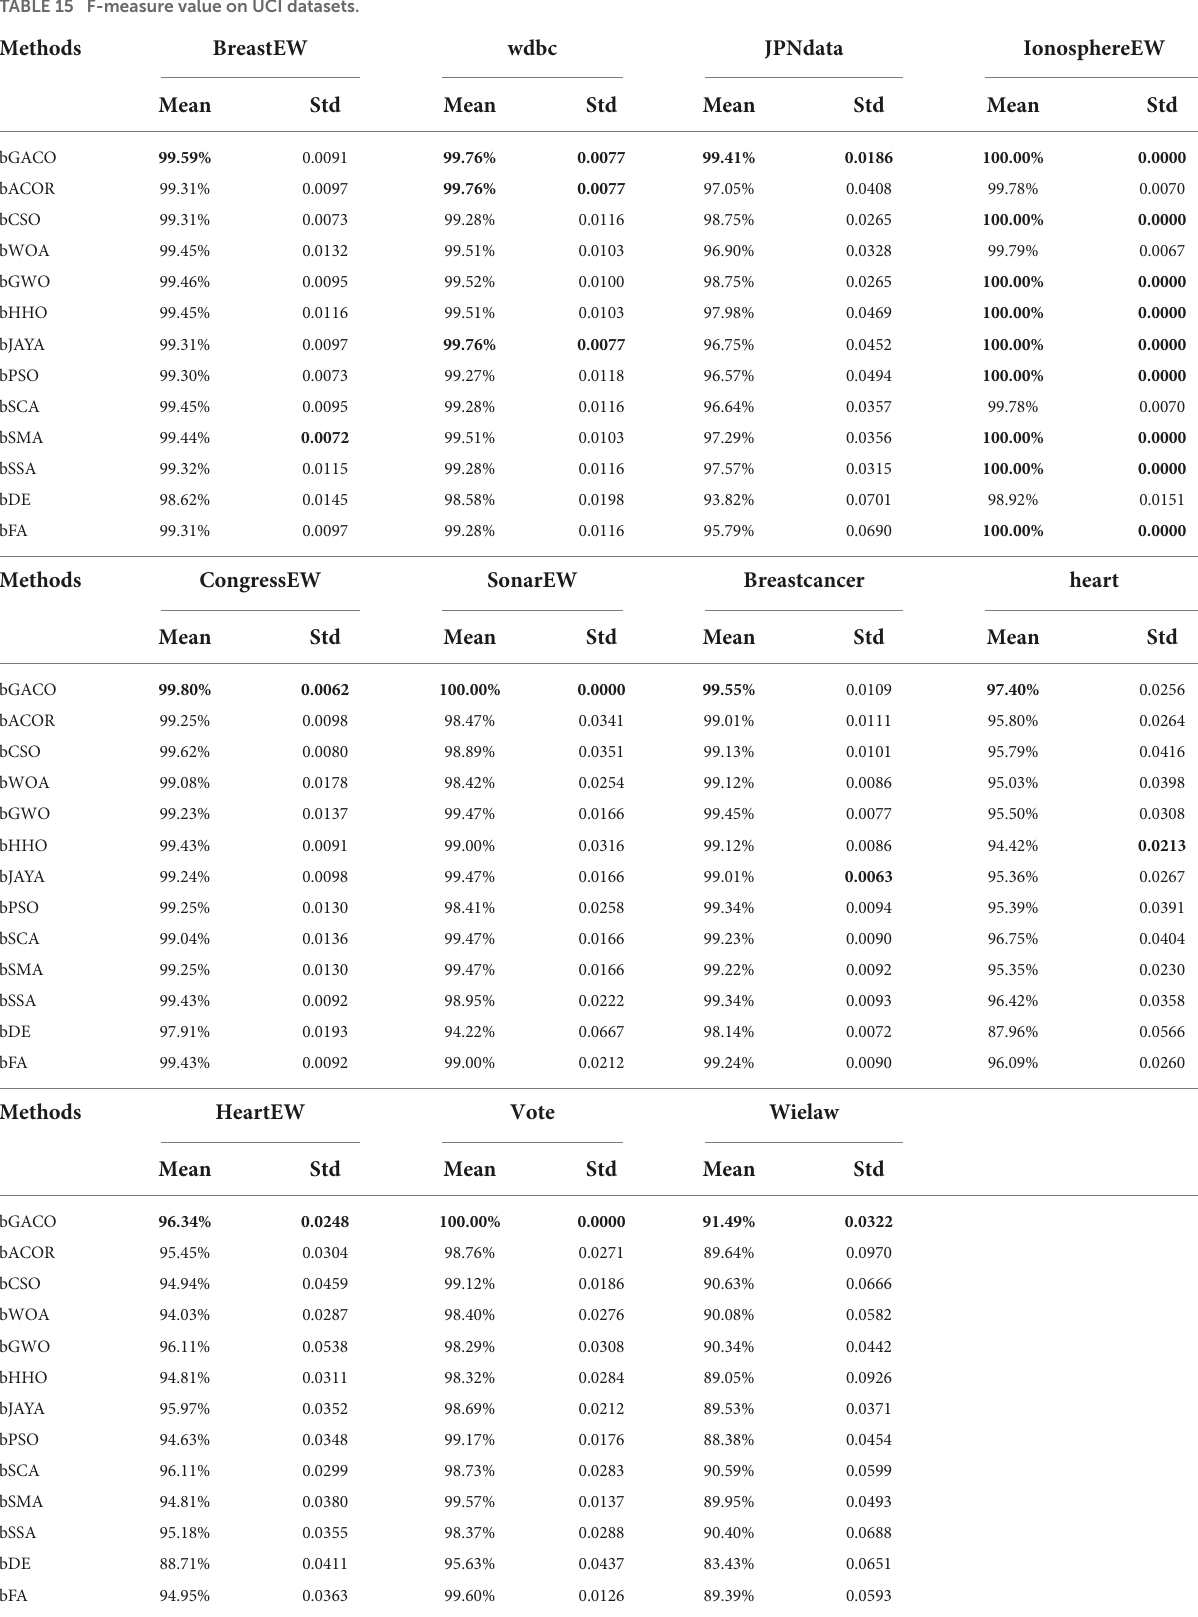
TABLE 15 F-measure value on UCI